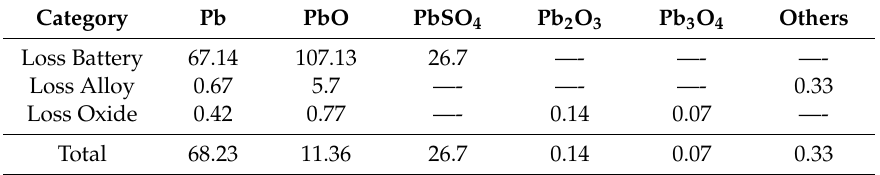
Table 4. The loss of various lead compounds in China’s lead manufacture stage in 2017. (Unit: kilo tons). Category Pb PbO PbSO 4 Pb 2 O 3 Pb 3 O 4 Others Loss Battery 67.14